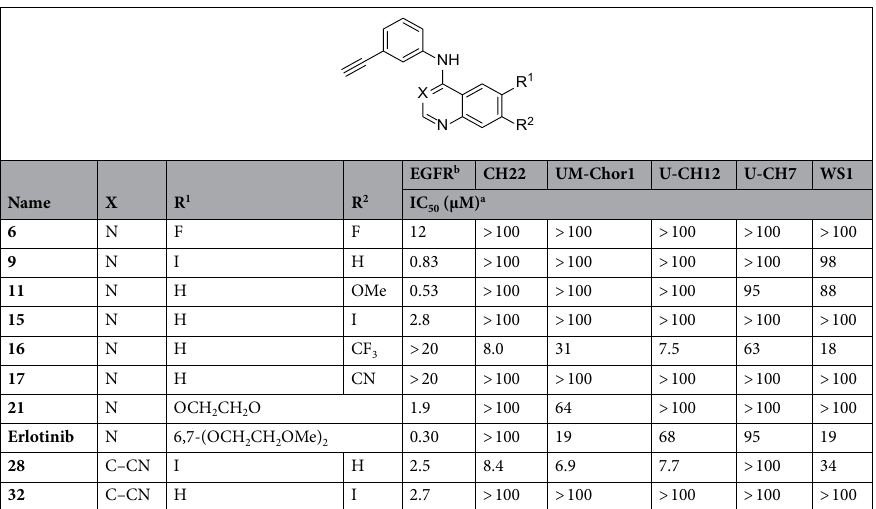
Table 3. Investigation of screening hits across four additional patient-derived chordoma cell lines and WS1 control. a Cell viability assay (n = 4). b ProQinase in-cell EGFR assay (n =